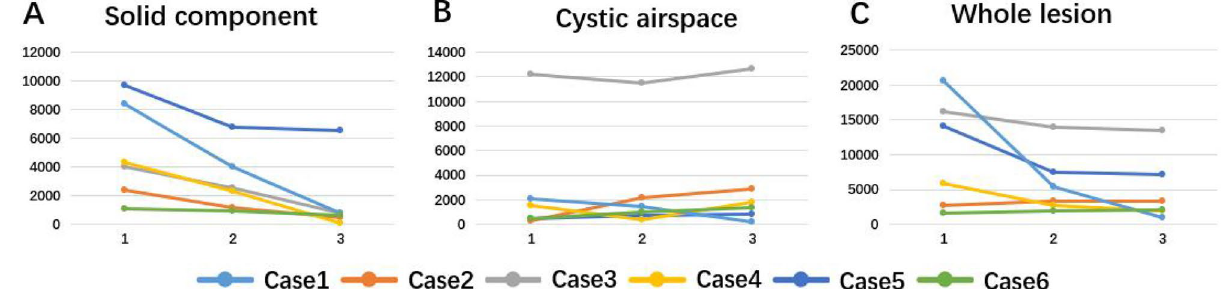
Figure 5. Changes in volume of different components after NC in six cases. The first abscissa represents the initial CT examination (Baseline) before NC, the second abscissa represents the first CT examination (First Time) during NC, and the last abscissa represents the last CT (Last Time) after NC. ( A ) Solid component; ( B ) cystic airspace; ( C ) whole lesion.